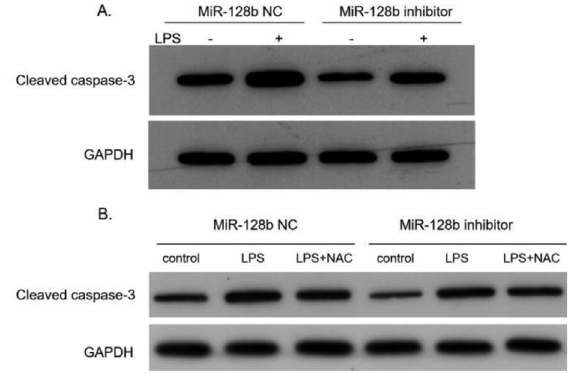
Figure 6. (A, B) Representative western blots of cleaved caspase-3 in Human Pulmonary microvascular Endothelial Cells (HPMECs) transfected with an miR- 128b inhibitor and NC. HPMECs were treated with LPS (1 μ g/mL) or NAC (10 μ M) ( n =